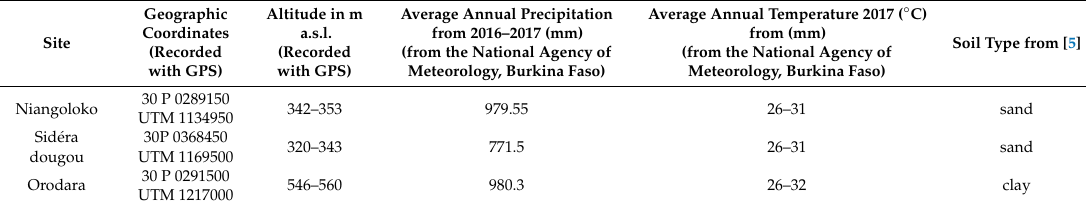
Table 1. Characteristics of the sampling sites.